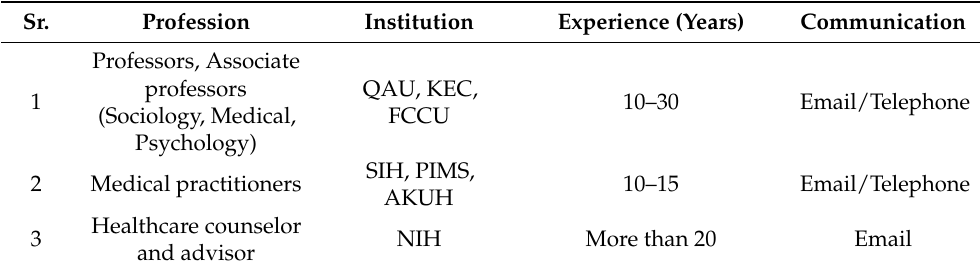
Table A1. Expert participants engaged in the assessment and testing of the questionnaire.